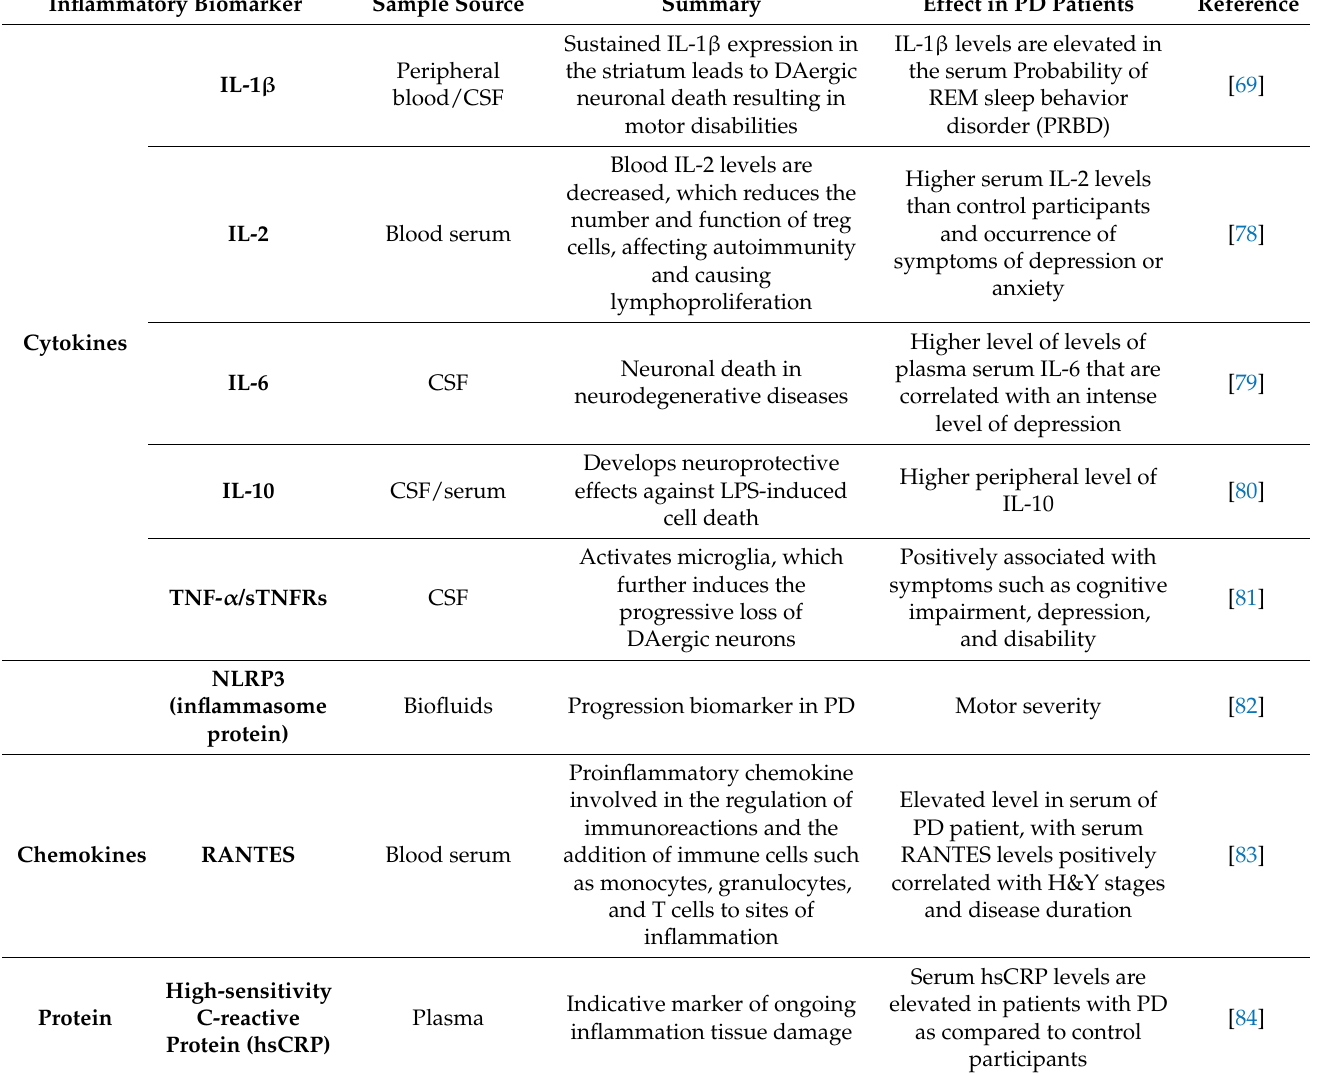
Table 1. Neuroinflammatory biomarkers and their action in PD patients. Inflammatory